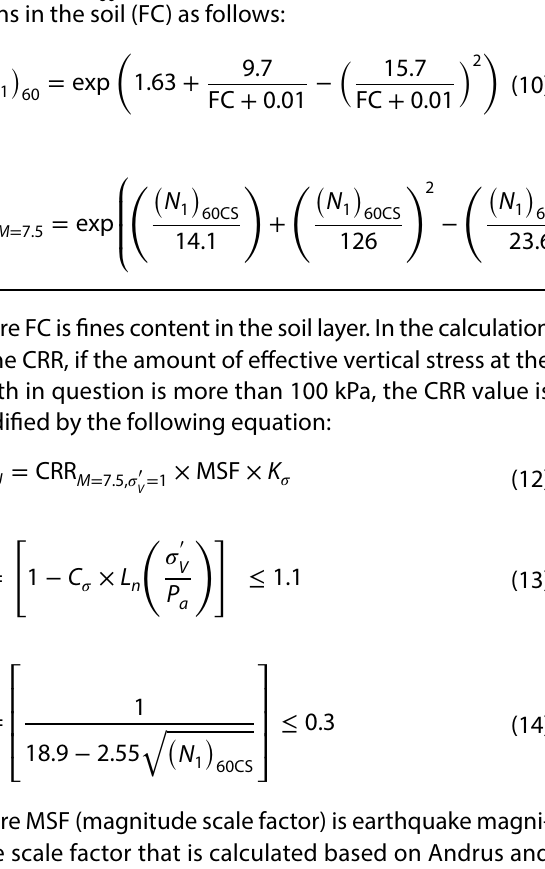
Stoke (1997) using Eq. 15.